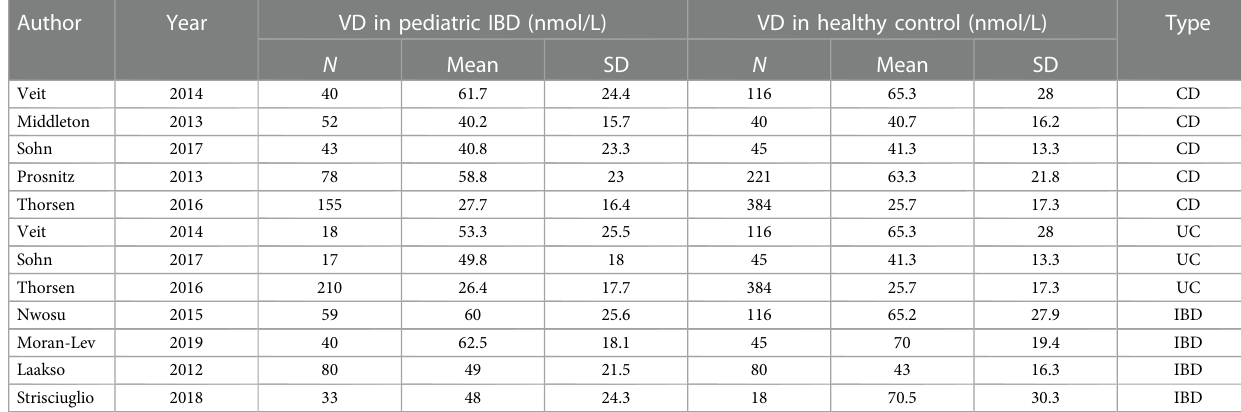
TABLE 2 The vitamin D levels in IBD patients and healthy